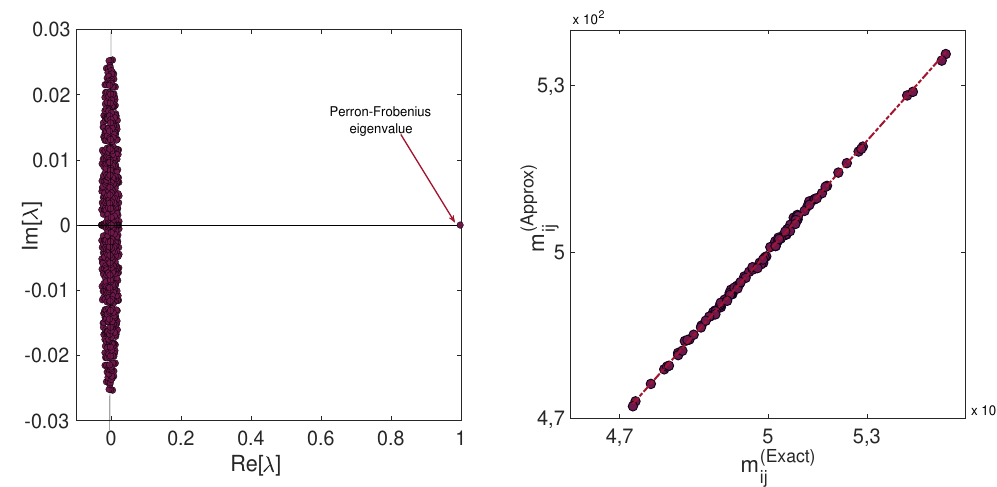
Figure 2: Left: eigenvalues in the complex plane for a typical instance of T ( j ) for the fully connected network described in section 3.1 with edge weights drawn from a uniform [ 0,1 ] distribution. Right: scatter plot of exact results (obtained by matrix inversion, see eq. (3)) vs. our approximate formula in eq. (5). Each point (100 in total) refers to a randomly picked ( i , j ) pair on a randomly generated instance of the graph. In dashed red, the straight line with slope = 1, indicating perfect